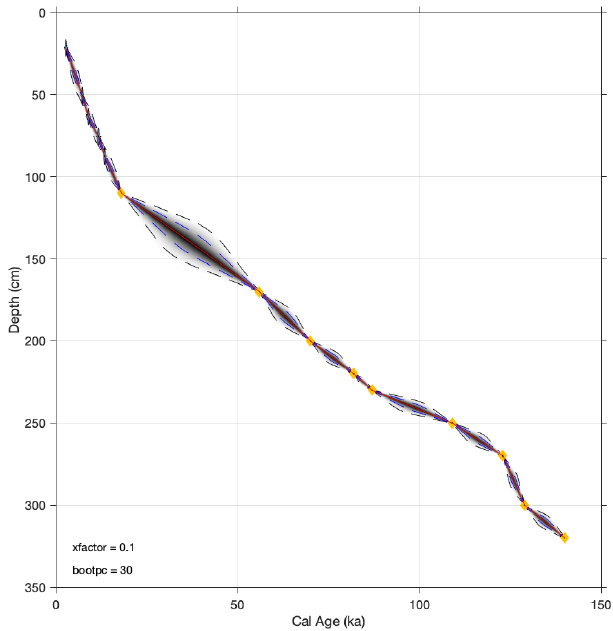
Figure 3. Age model of TAN1302-96. Tie points are depicted as yellow dots, and grey shading represents associated uncertainty be- tween tie points. The age model used a marine reservoir calibration of 1000 ± 100